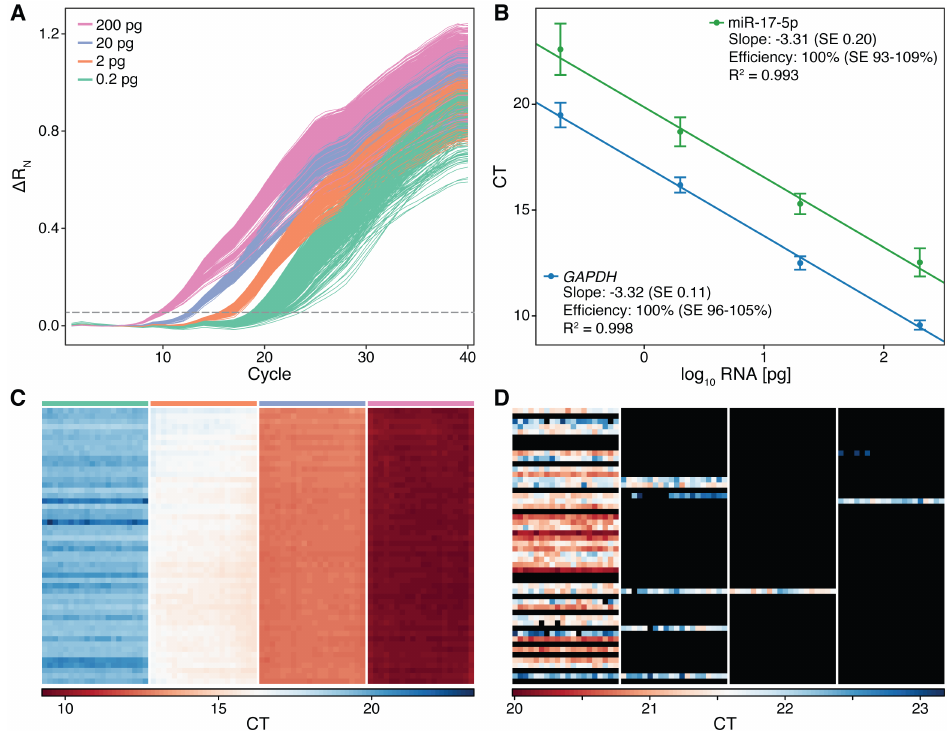
Fig 2. Device characterization and performance. (A) 4,160 real-time amplification curves generated from one experiment on a 10 × dilution series of purified total K562 RNA. Each curve is generated from processing fluorescence images of the entire device taken after each cycle of PCR. The threshold for determining CT values is indicated by the dashed line. (B) Standard curves derived from three replicate 10 × dilution series of K562 RNA that validate the one- and two-step workflows measured using GAPDH (blue) and miR-17-5p (green), respectively. Points represent the mean ± standard deviation of all 1040 detection chambers per concentration from all three replicates. Input RNA ranged from 200 pg (10 cell equivalent) to 0.2 pg (1/100 cell equivalent) per cell processing unit. (C) Heatmap representation of the CT values extracted from the real-time curves shown in A. Values are organized according to the device layout; the leftmost panel corresponds to the lowest concentration, the rightmost panel corresponds to the highest concentration and each row within each panel originates from the same cell-processing unit. The three rightmost panels (200–2 pg/cell processing unit) indicate uniform amplification across the device. The variability within the leftmost panel (0.2 pg/cell processing unit) is much higher than that within each cell-processing unit (row), illustrating the increased contribution of stochastic sampling towards the variability of this measurement. (D) Heatmap of CT values for GAPDH measured on a 5 × dilution series at limiting RNA concentrations. Values are organized according to device layout, with the highest concentration seen on the left. Black cells were not detected. After sufficient PCR pre-amplification, cell-processing units that initially contained a single cDNA molecule were amplified to levels such that signal is produced in an average of 19.8/20 detection